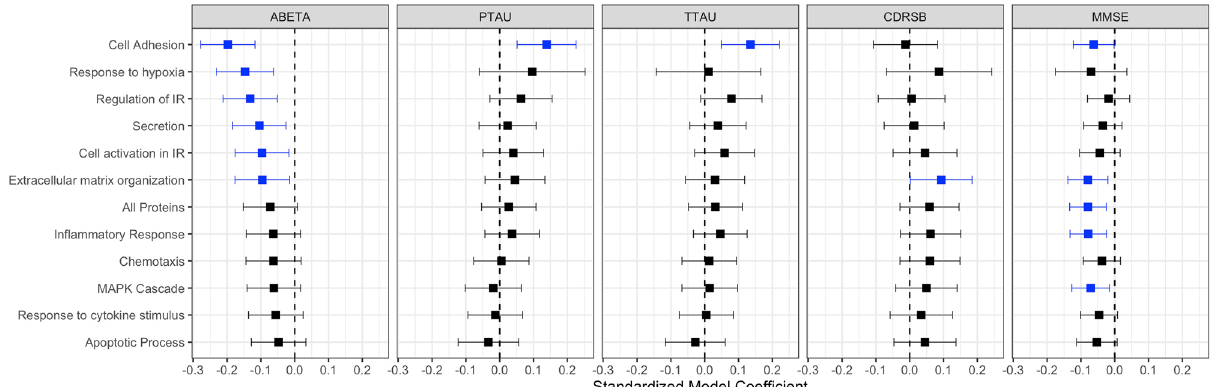
Figure 5. Association between Plasma-based proteomic aging and core AD biomarkers. This figure shows the association between plasma-based InflammAGE scores (i.e. the difference between an individual’s inflammatory age and their chronological age) and various core biomarkers of AD—amyloid accumulation, tau accumulation, general neurodegeneration, and cognitive